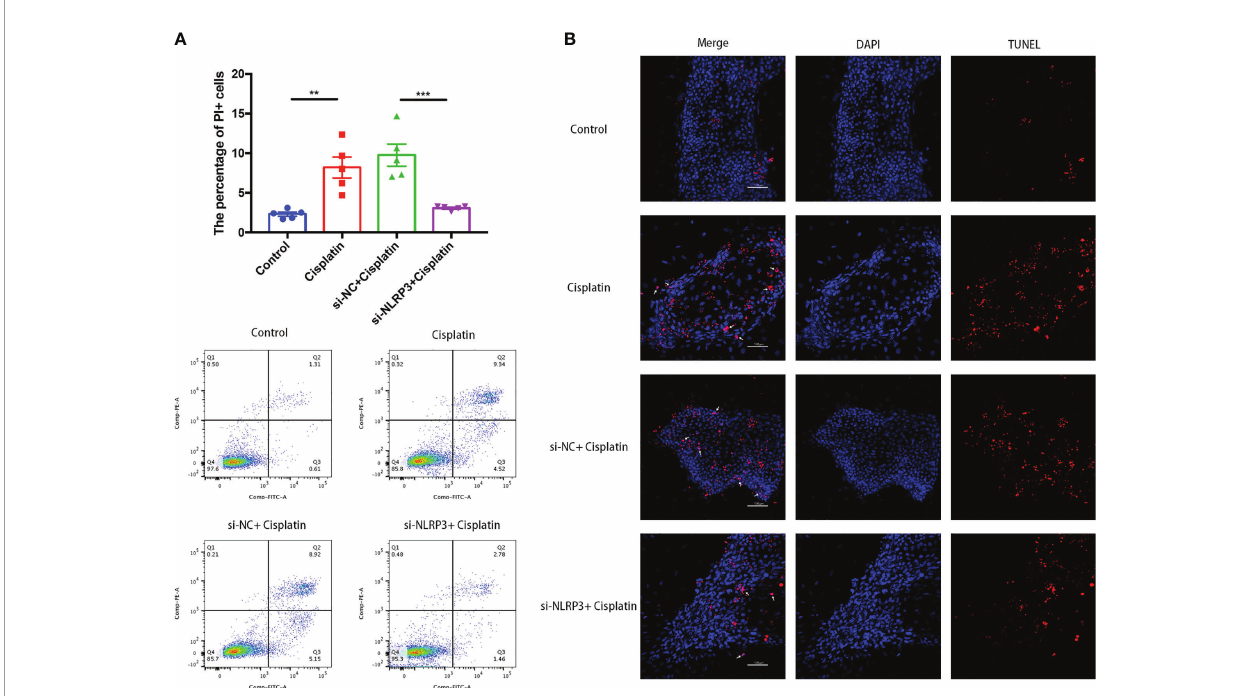
FIGURE 3 | Downregulation of NLRP3 decreased the number of MCs with cell membrane rupture (A) or DNA rupture (B) . (A) The differences in the percentage of MCs with cell membrane rupture (the cells in the Q1 and Q2 quadrants) between the groups. (B) The differences in the percentage of MCs with DNA fracture (TUNEL positive) between the groups. Blue fl uorescence indicates DAPI-labeled cell nuclei, and red fl uorescence indicates DNA fragmentation labeled with Alexa Fluor 640. The red fl uorescence overlapping with the nucleus was judged to be TUNEL-positive cells (white arrows). Scale bar: 100 µm. Representative results of at least three repeated experiments are shown. **p < 0.01, ***p <